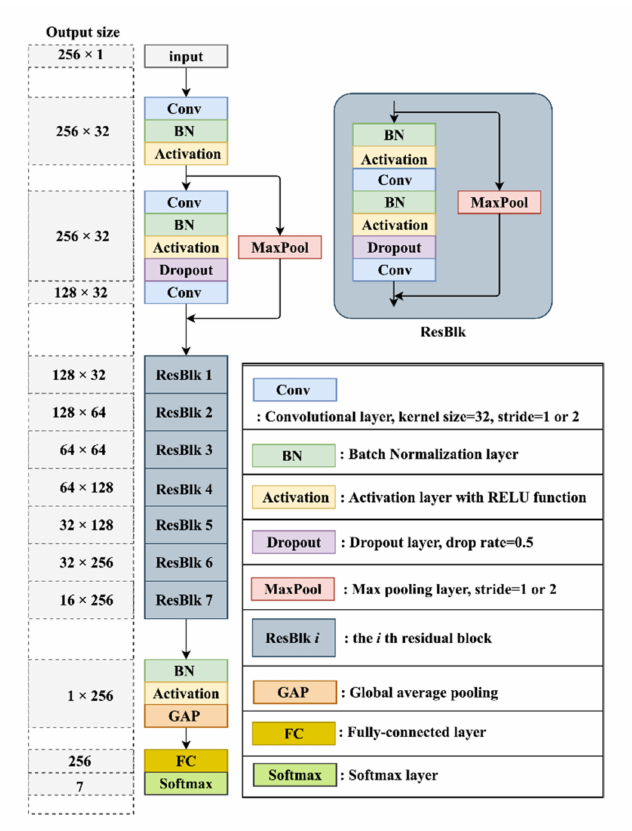
Figure 5. The detailed architecture of a branch